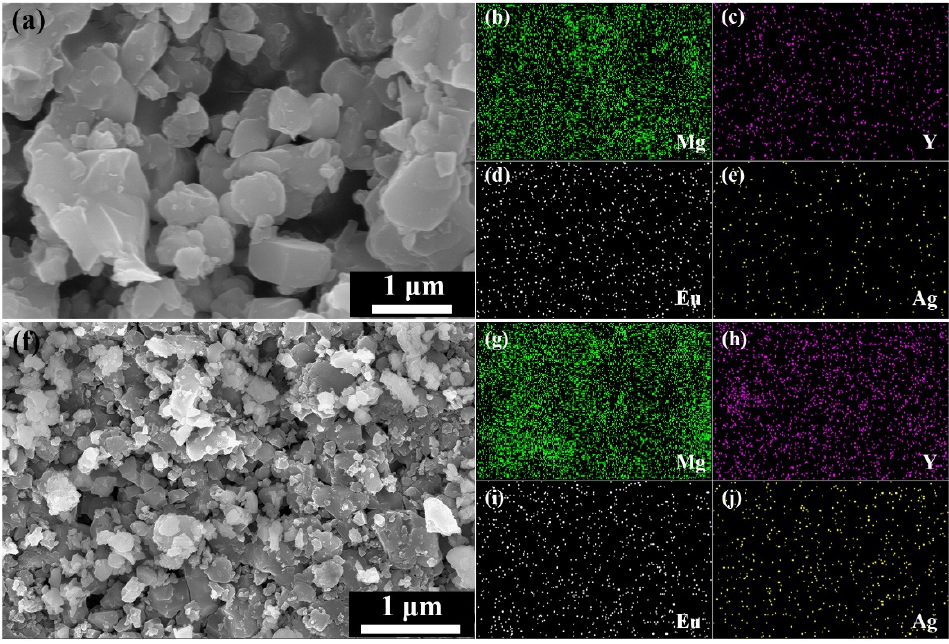
Figure 5. ( a ) SEM image and ( b – e ) EDS mapping of a MgB 2 + 0.5% Y 2 O 3 :Eu 3+ /Ag. ( f ) SEM image and ( g – j ) EDS mapping of c MgB 2 + 1.2% Y 2 O 3 :Eu 3+ /Ag.